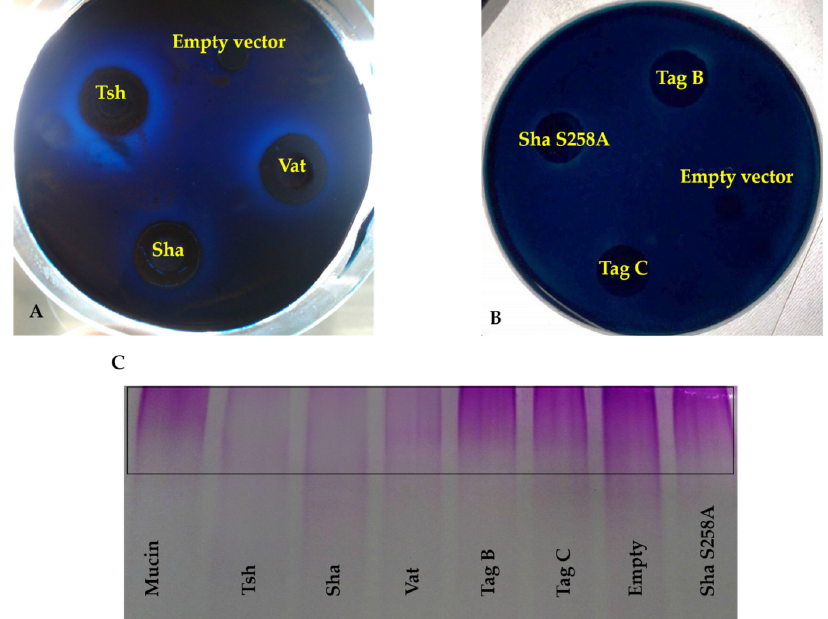
Figure 7. Sha demonstrates serine-protease dependent mucinase activity, but not TagB nor TagC. Mucinase activity was tested in a medium containing 1.5% agarose and 0.5% porcine gastric mucin. Filter discs inoculated with clones containing the empty vector, expressing Sha, Vat, Tsh, ( A ) TagB, TagC, or Sha S258A ( B ) were placed on the agar surface and incubated overnight at 37 ◦ C. Mucin lysis zones were visualized by staining with 0.1% amido-black in 3.5 M acetic acid for 15 min, followed by destaining with 5% acetic acid and 0.5% glycerol for 6 h to overnight. ( C ) Zones of 0.5% porcine gastric mucin hydrolysis are visible in the stacking region of the SDS-PAGE gel (boxed area), concentrated supernatant extracts of SPATEs (5 µ g of protein per well) were incubated at 37 ◦ C for 48 h with mucin prior to migration. The gel was stained with a PAS glycoprotein staining